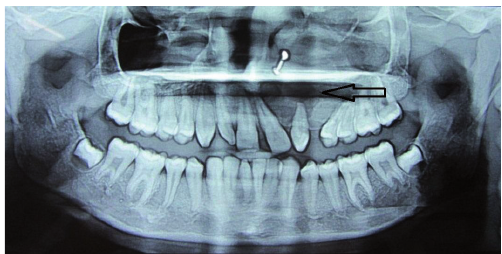
Figure 2: Orthopantomograph showing ill-defined mixed radiolu- cency in the left maxilla with displacement of the adjacent teeth.